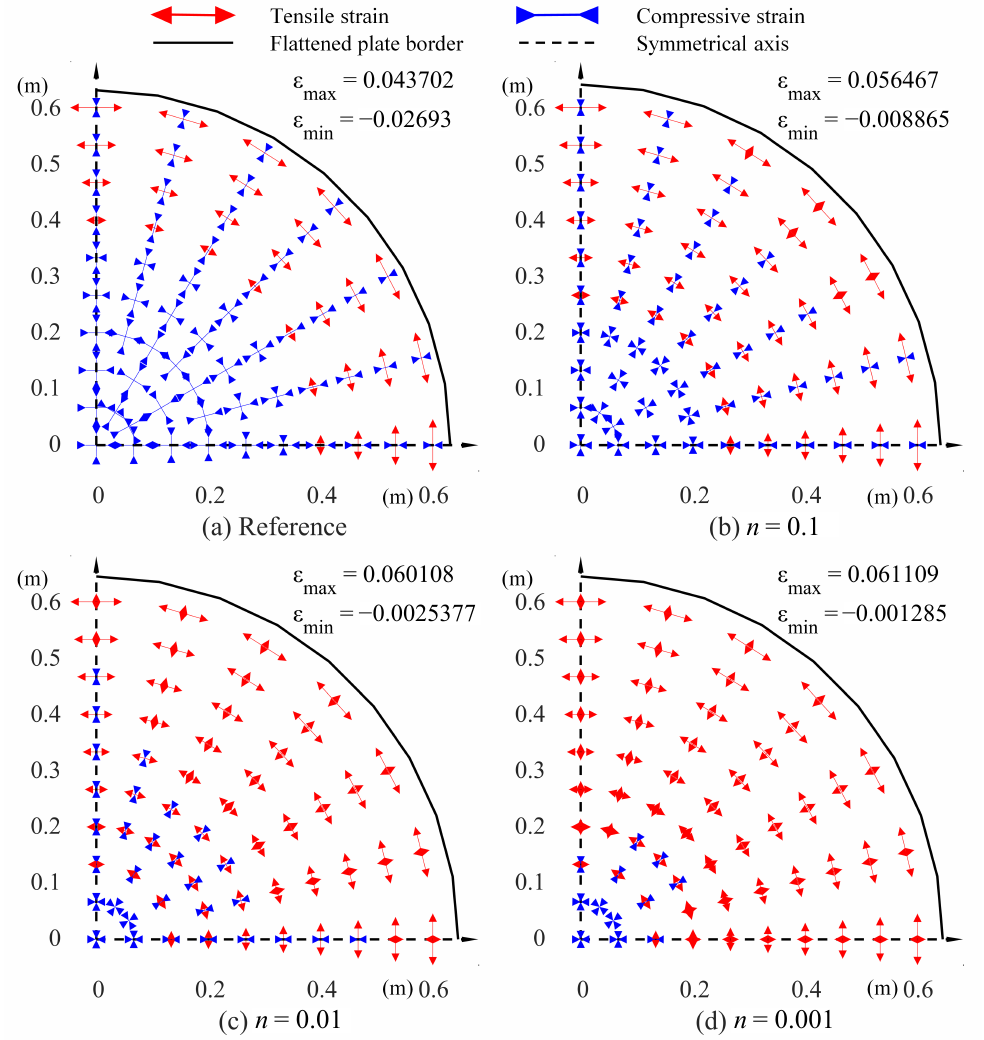
Figure 6. Principal membrane strain vector of spherical cap flattening with dominating tensile strain ( a ) reference, (b) n = 0.1, ( c ) n = 0.01, ( d ) n =